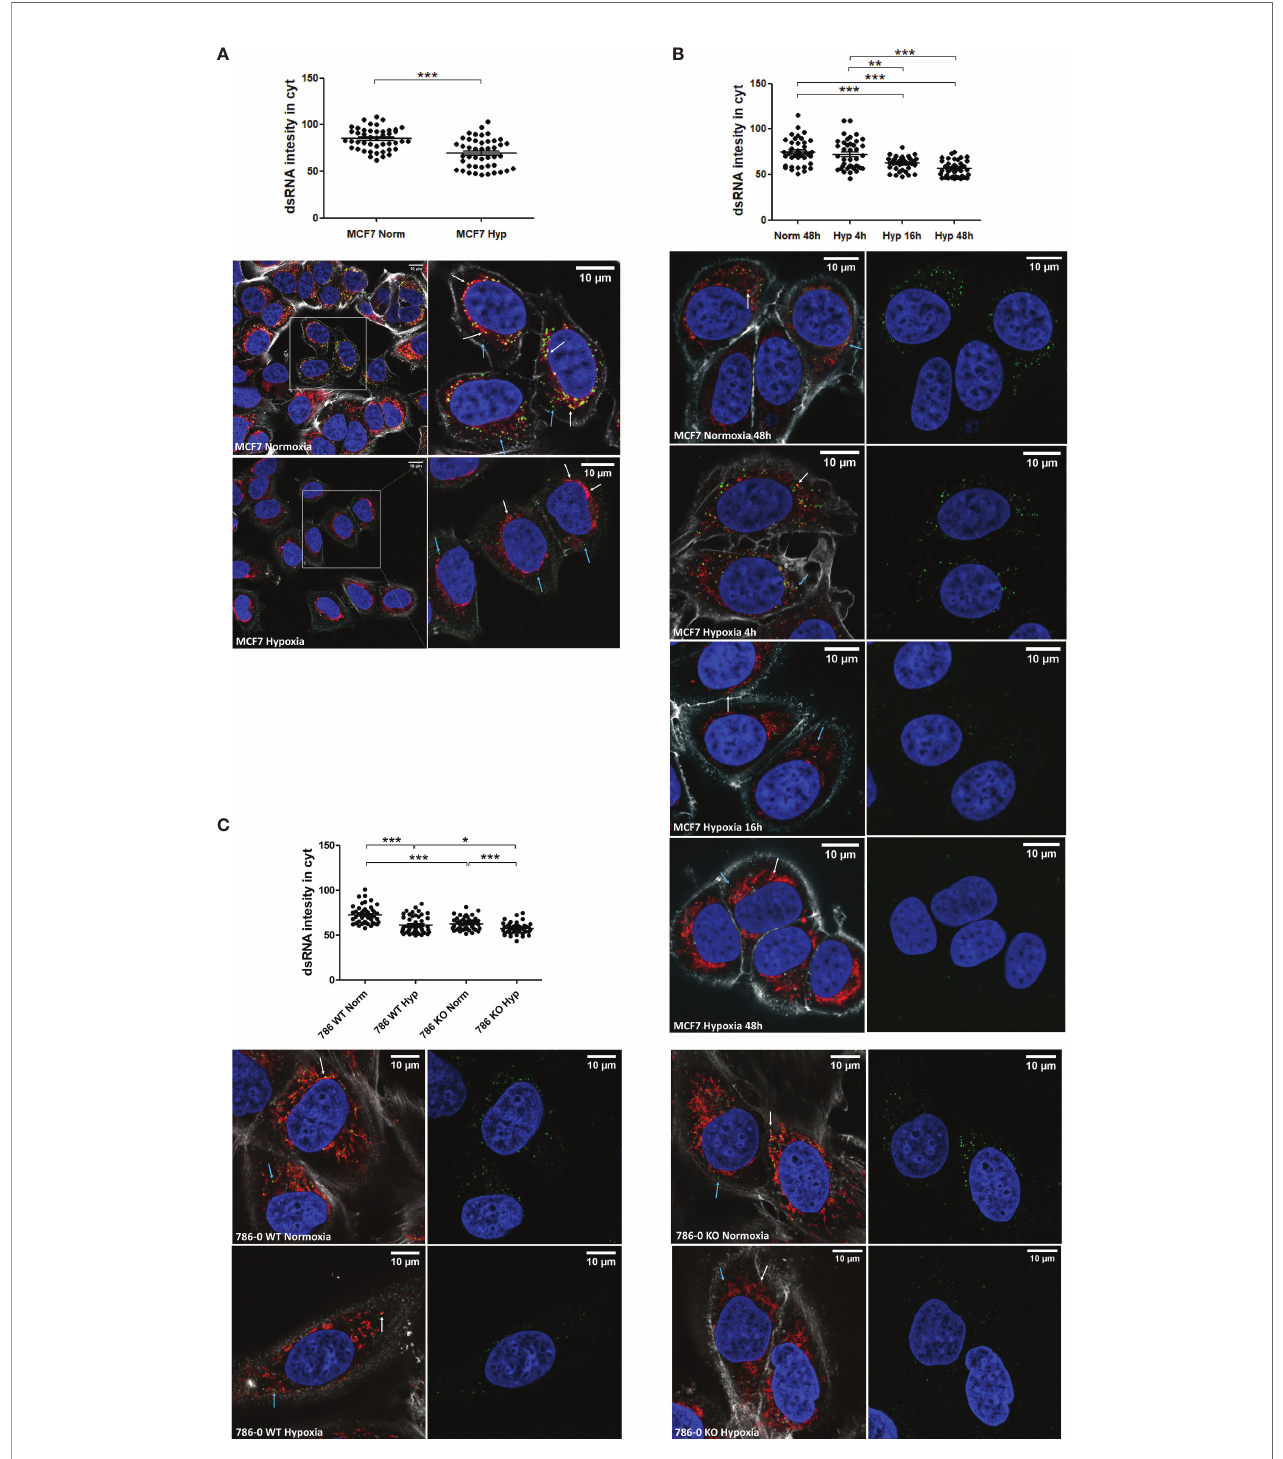
FIGURE 2 | dsRNA staining is signi fi cantly lower under hypoxia independently of HIF1 a /2 a expression. (A) dsRNA was stained using J2 antibody in MCF7 cells exposed to normoxia (n=45 cells) or 0.1% hypoxia (n=45 cells) for 48h from 3 independent replicates. (B) dsRNA was monitored during a time course of MCF7 cells in normoxia (n=40 cells), or exposed to 0.1% for 4h (n=40 cells), 16h (n=40 cells), and 48h (n=40 cells) from 3 independent replicates. (C) HIF1 a /2 a involvement was evaluated by staining dsRNA in 786-0 WT cells (786 WT, n=46 normoxic cells and n=46 hypoxic cells), and 786-0 HIF2 a -KO cells (786 KO, n= 45 normoxic cells and n=45 hypoxic cells) from 3 independent replicates. Data is shown as mean ± SEM. *p < 0.05, **p < 0.01, ***p < 0.001. Green: J2 antibody staining, blue: DAPI, and red: MitoTracker staining. White arrow: dsRNA inside of mitochondria, blue arrow: dsRNA outside of mitochondria. Scale bars correspond to 10 m